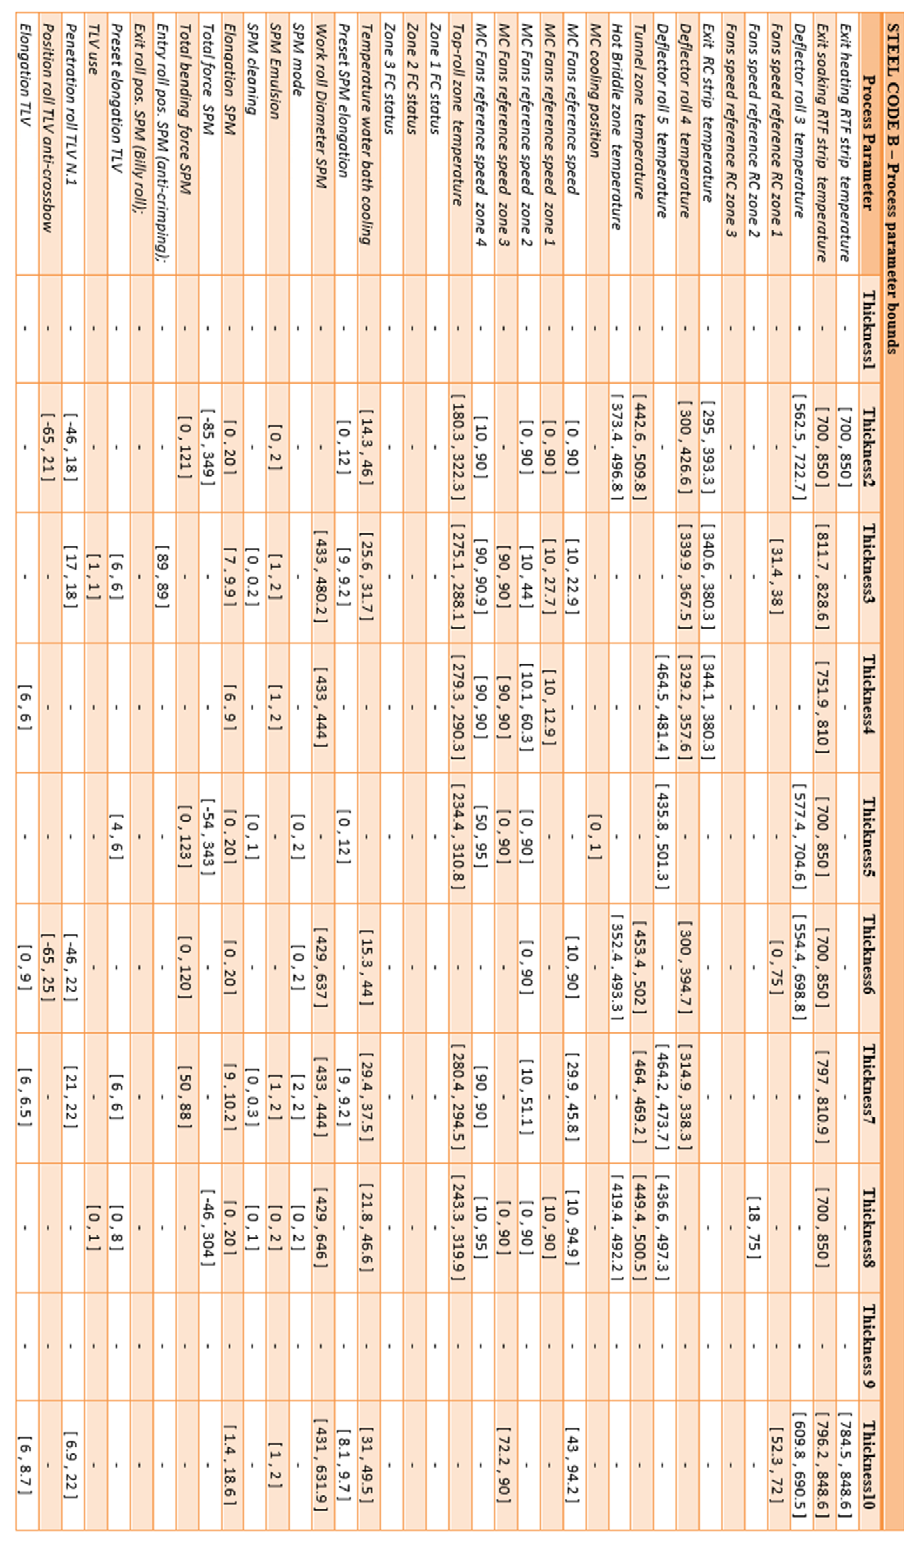
Figure A2. Process parameter bounds for Steel Code B by thickness range.